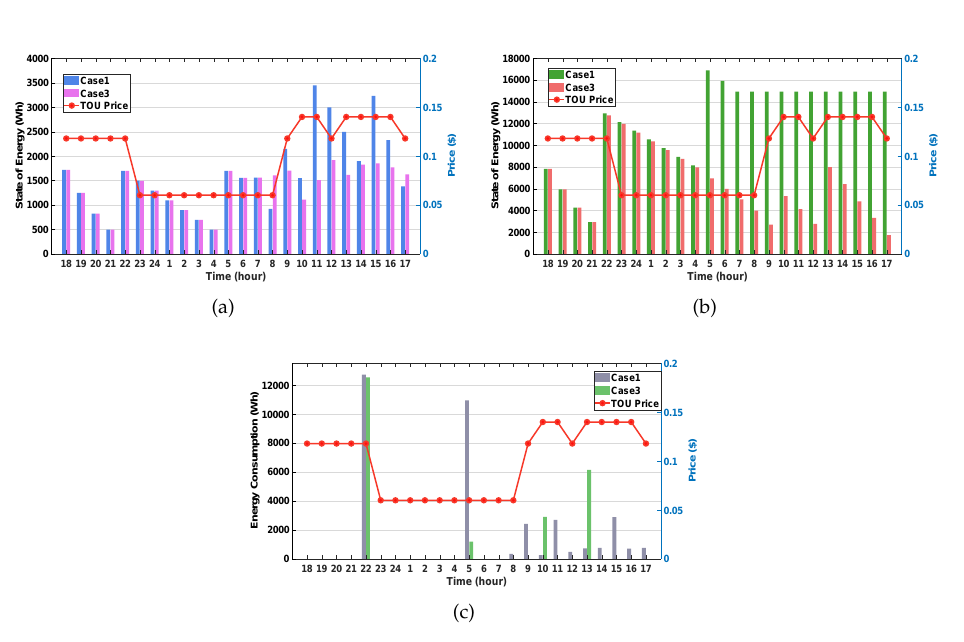
Figure 6. Performance comparison between Case 1 and Case 3. ( a ) SOE of the ESS; ( b ) SOE of the EV; ( c ) net consumption of